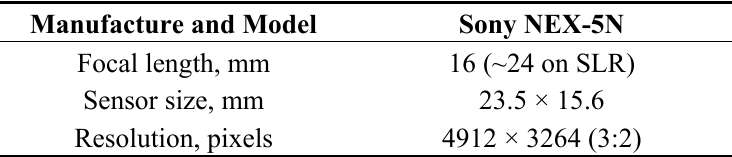
Table 1. Details of the camera used on the MK Okto